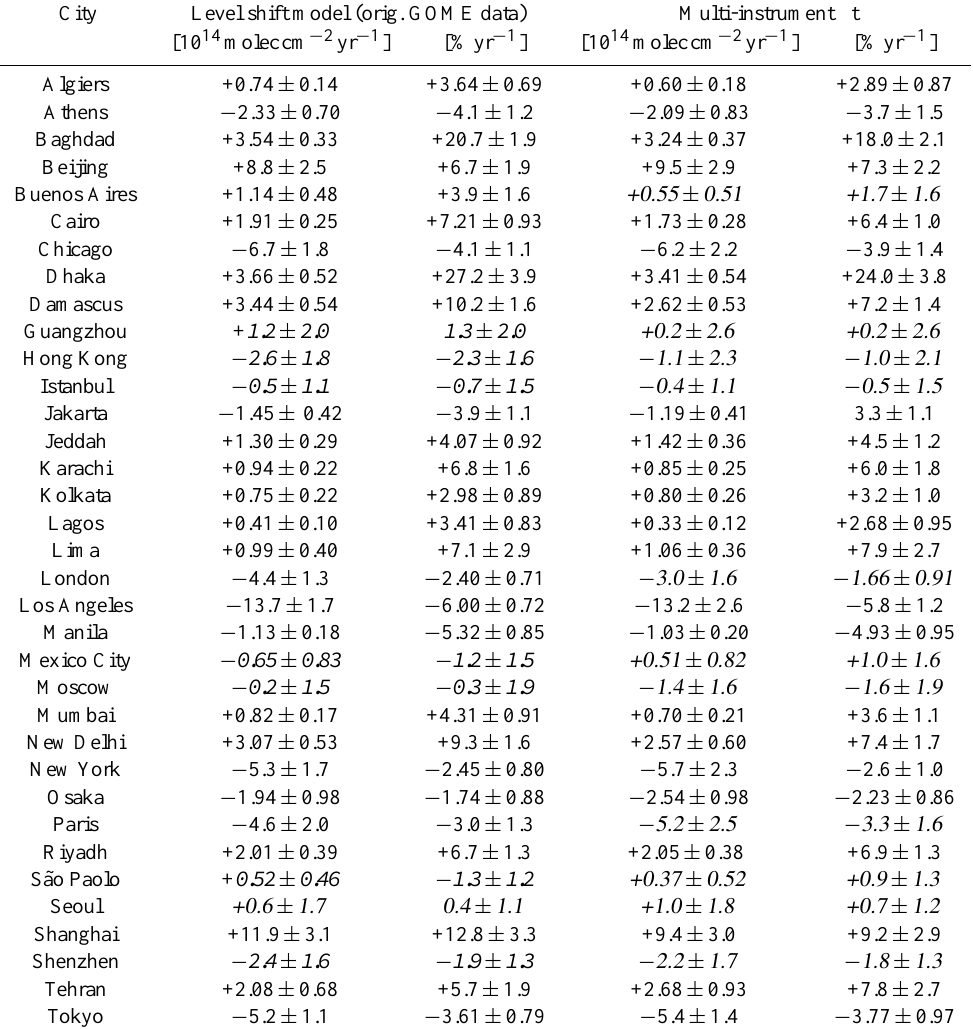
Table 4. Annual growth rate 1 VCD trop NO 2 from the level shift model (Eq. 3) and the multi-instrument fit (Eq. 9) for a list of megacities. The relative trends have been computed relative to the 1996 annual mean. Non-significant trends (see Eq. 6) are shown in